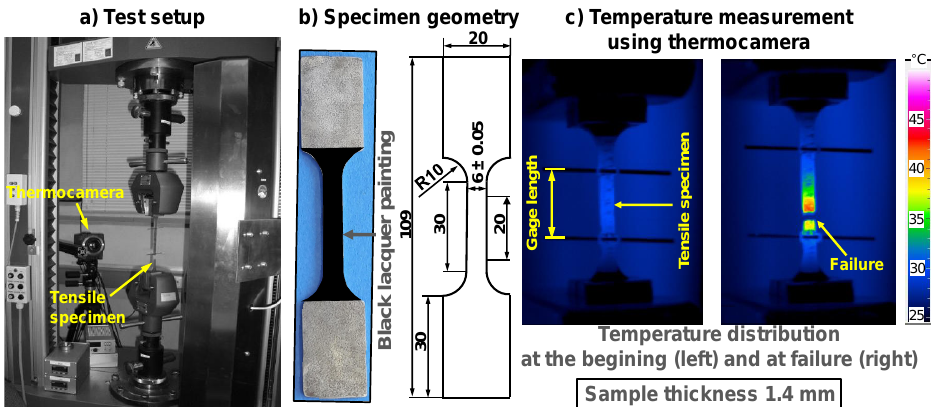
Figure A2. Temperature measurement setup using Macro-Tensile tests carried out in conjunction with high-resolution thermocamera for investigating the rise in temperature due to adiabatic heating. ( a ) Tensile testing machine depicting the thermocamera, tensile sample, ( b ) sample painted with black lacquer painting to minimize the reflections from the surroundings, ( c ) Image acquisition and analysis using IRBIS ® online